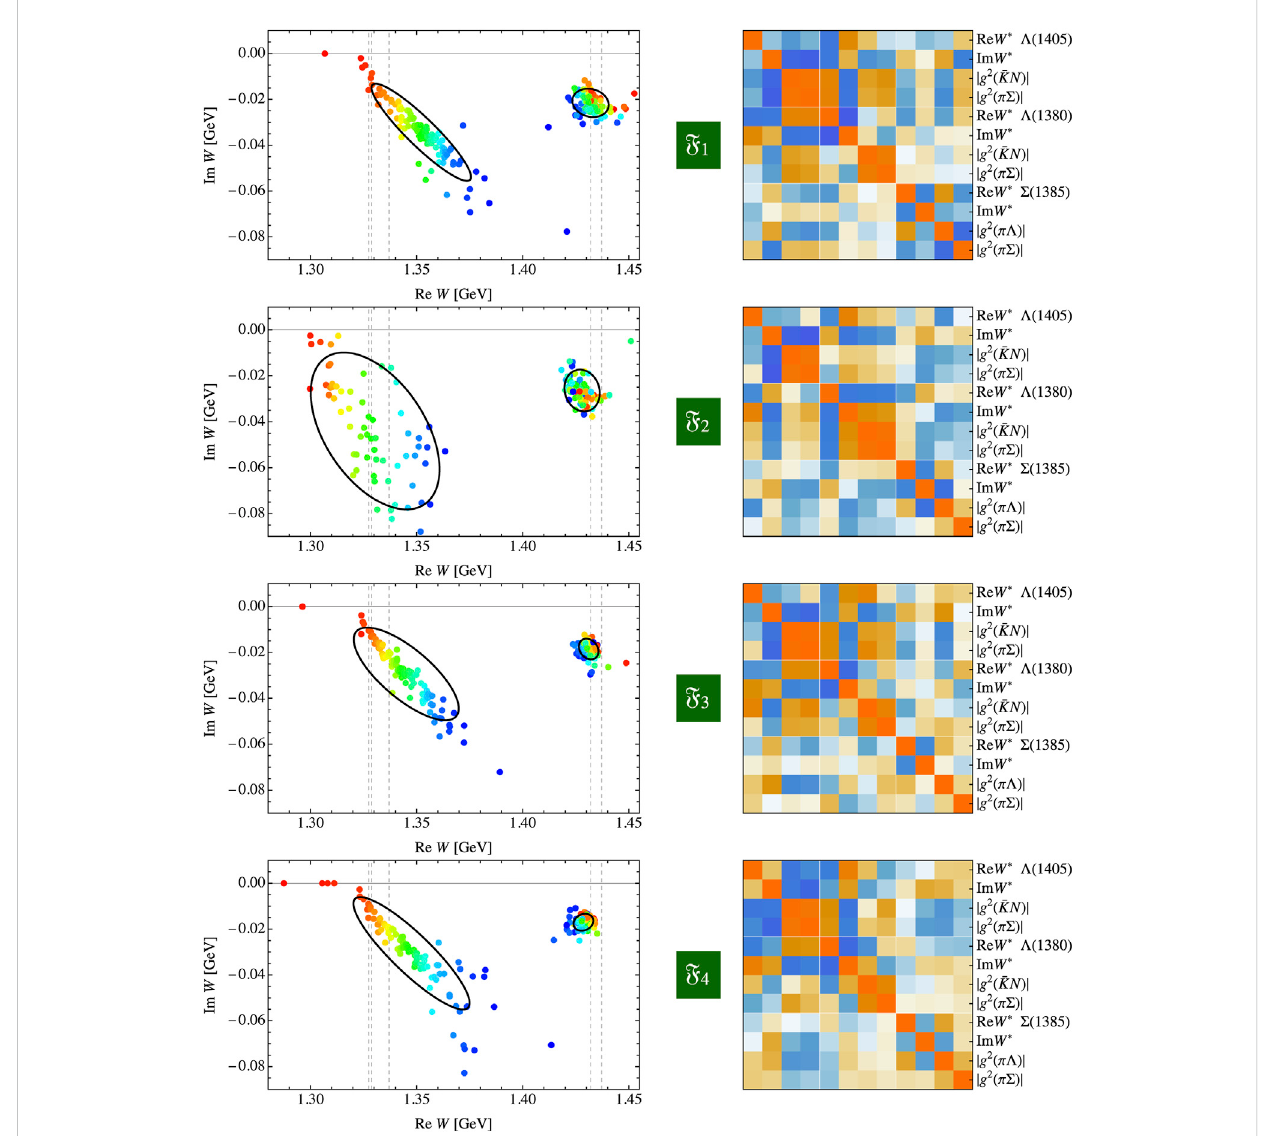
FIGURE 4 Comparison of all fi t strategies. Left column : Correlations between the pole positions of the Λ (1380) and Λ (1405) resonances for different fi t strategies. Eachpointcorrespondstoapolefromare-samplingsolution.Pointsofthesamehuebelongtothesamesample. Rightcolumn :Correlations between pole positions and couplings. The redder the square the stronger the positive correlation and the bluer the square the stronger the negative